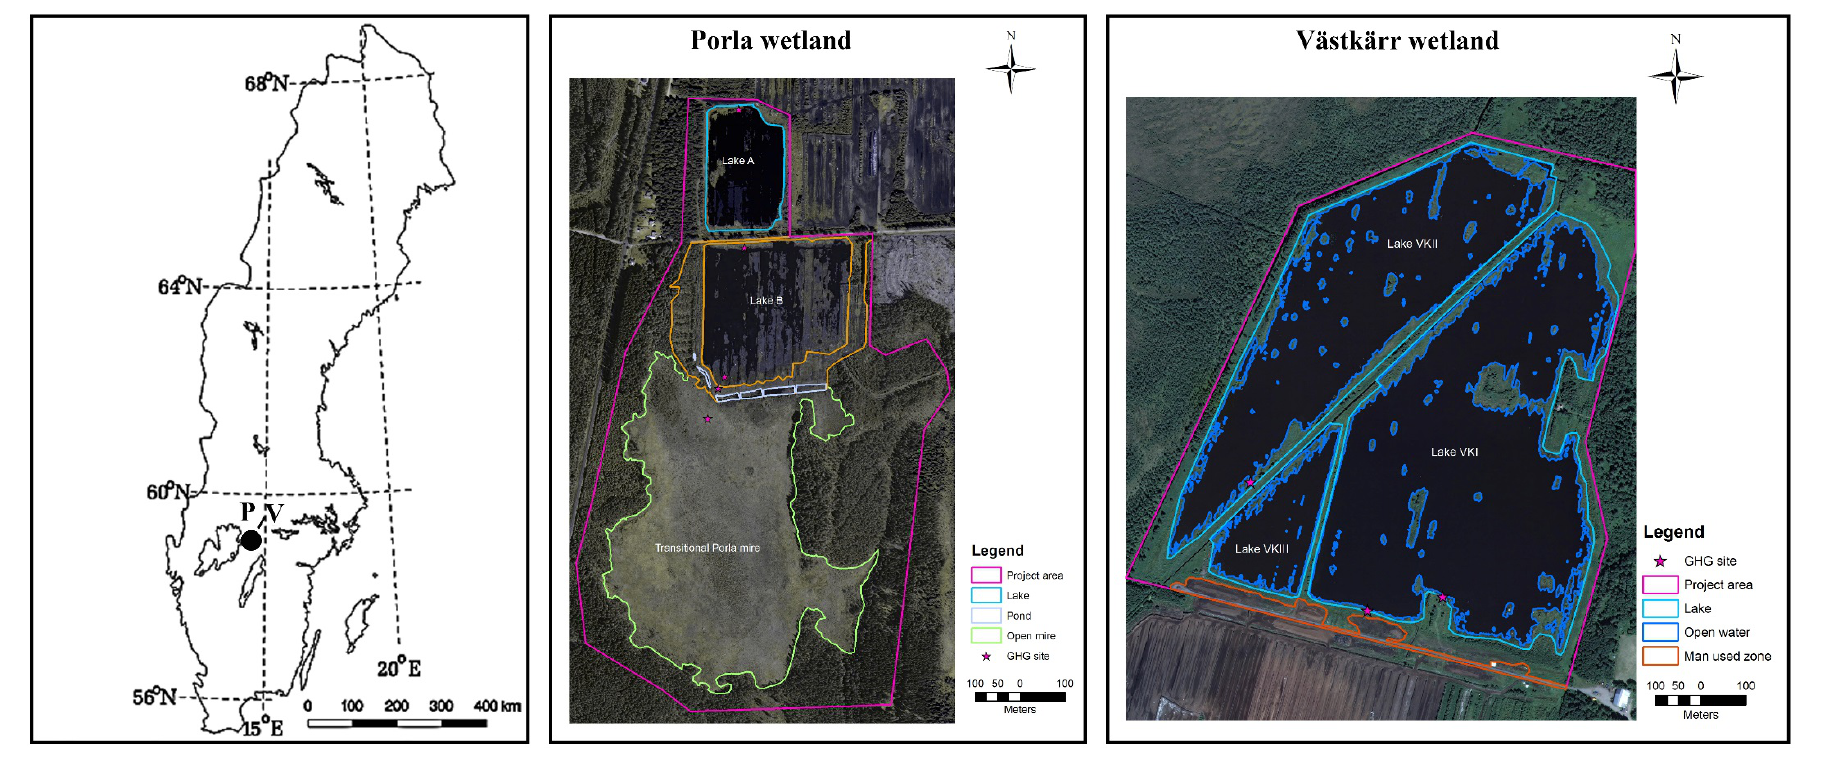
Figure 1. Map of Sweden showing the locations of the two rewetting areas Porla (P) and Västkärr (V), which are only 12 km apart. Västkärr is immediately to the east, and Porla 6 km to the south-west, of the raised bog known as